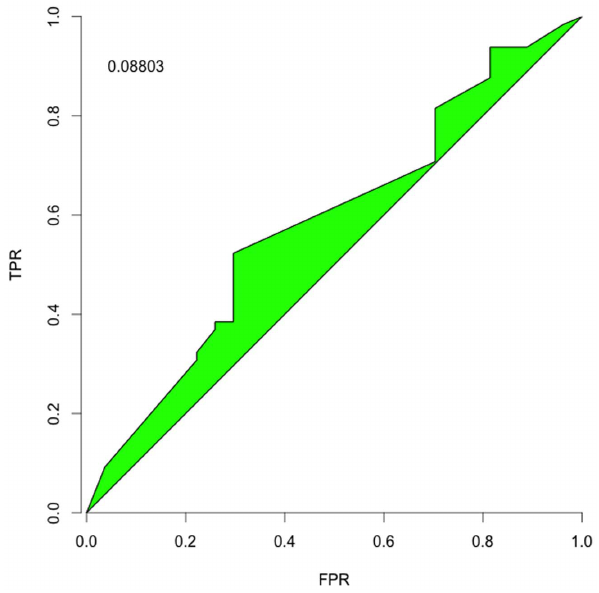
Figure 6. Non-Inhibition Identification. The ROC for identifying non-interactions between components in the yeast cell